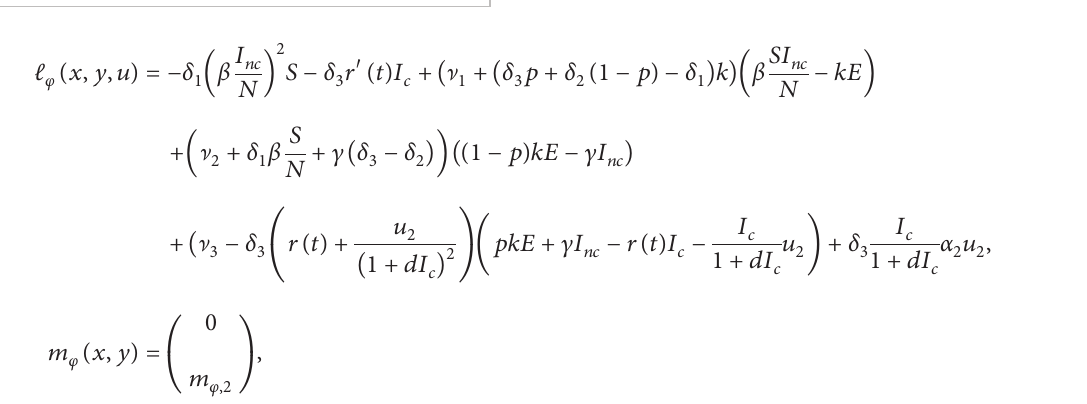
� 0 . 6, σ � 1, and u max � 0 . 1 1